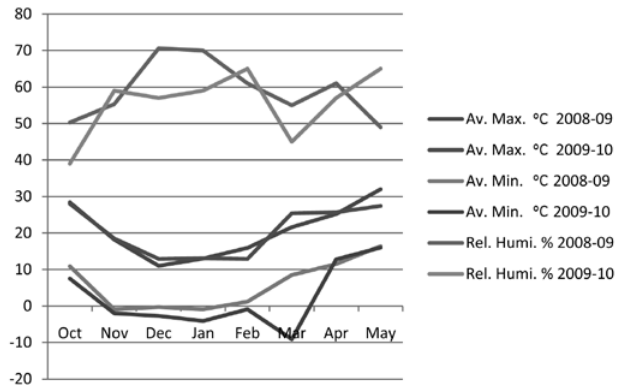
Table 1 - Growth and flowering characters of strawberry cultivars under polyhouse Plant spread (cm) No. of runners/ plant Cultivar